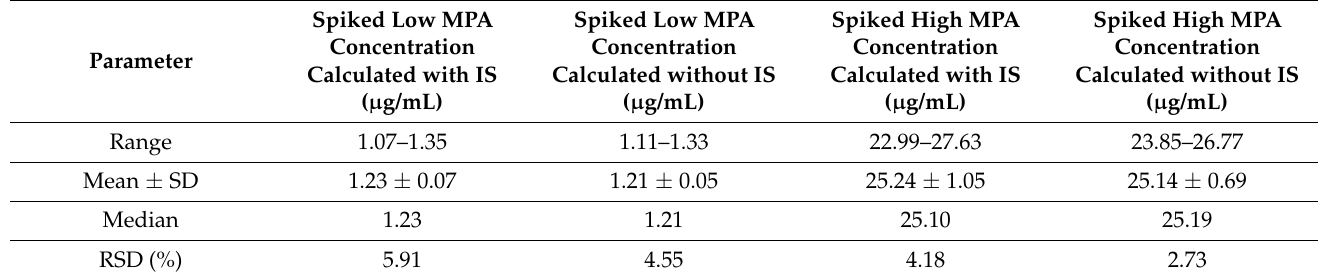
Table 6. MPA concentrations in spiked plasma samples ( n = 45 +